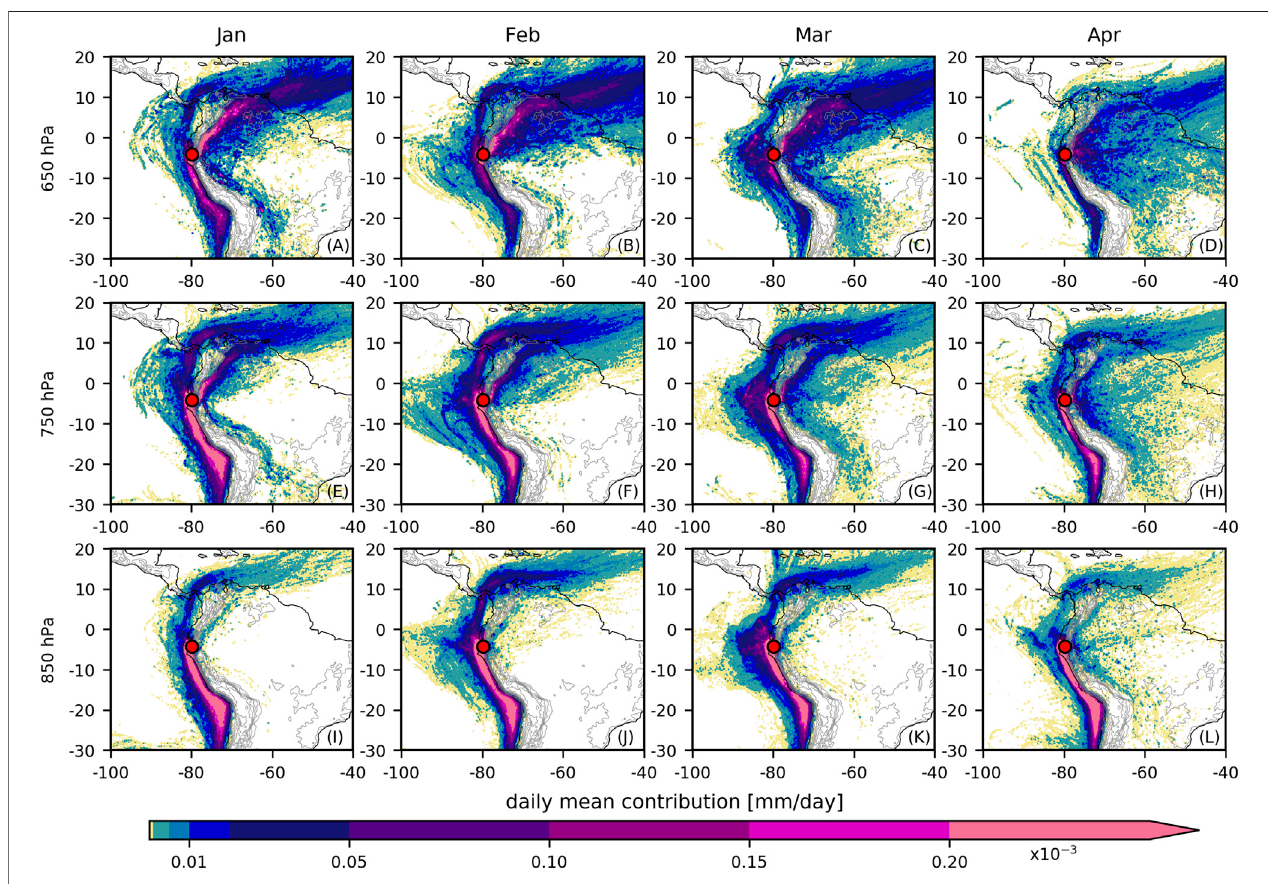
FIGURE 7 | As Figure 6 , but for the composites of each month [January (A,E,I) , February (B,F,J) , March (C,G,K) , April (D,H,L) ].